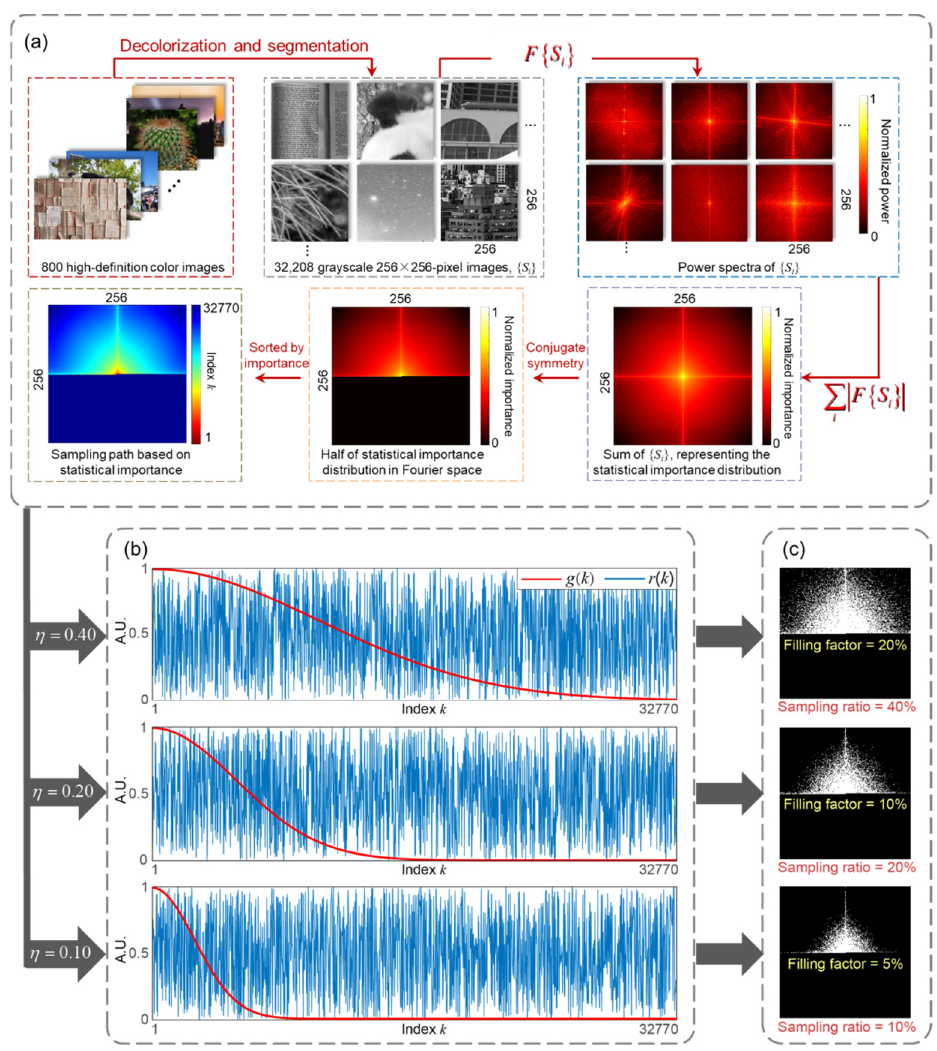
Figure 2. The generation of Gaussian random sampling mask by the proposed method. In the first step ( a ), the important distribution of coefficients in the Fourier domain is obtained through statistics. Images from a database are decolorized and segmented to M × N pixels. Fourier transform is applied to each segmented sub image and the moduli at the corresponding locations of the resulting Fourier spectra are summed up. Discarding the conjugate symmetric coefficients in the summed spectrum, the remaining coefficients are sorted in a descending order. Each sorted coefficient has its own index k , which indicates the importance of the coefficient. The smaller the index is, the higher the importance of the coefficient. In the second step ( b ), a uniformly distributed random function r ( k ) and a Gaussian function g ( k ) with a specific sampling ratio, η , are generated. In the third step ( c ), all Fourier coefficients, whose index k satisfies g ( k ) > r ( k ) , are marked as ‘to be sampled’ (white pixel) in the sampling mask. Filling factor is defined as the ratio of marked coefficients to all coefficients in the Fourier space, which is also one half of the sampling ratio (due to the conjugate symmetry).